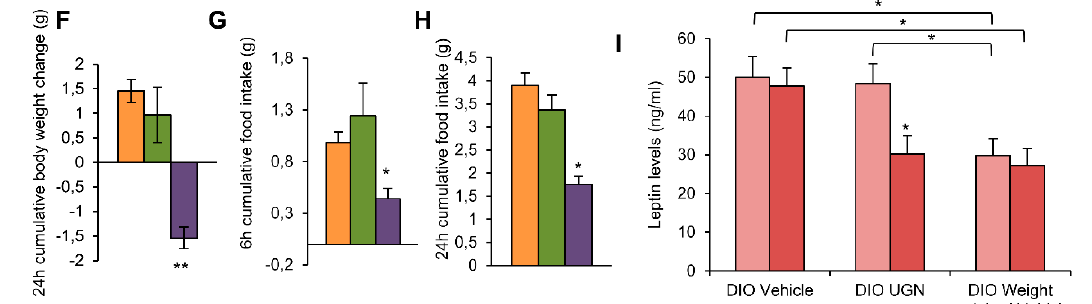
Figure 5. Effect of chronic ICV UGN (25 µ g/mouse) injection for four days and ICV leptin (3 µ g/mouse) for 24 h in DIO mice and weight-matched DIO mice on body weight ( A ). Effect of chronic ICV saline or UGN (25 µ g/mouse) injection for three days on body weight change ( B ) and food intake (C) in DIO mice. Effect of chronic ICV saline or UGN (25 µ g/mouse) injection for three days on body weight change ( D ) and food intake ( E ) in weight-matched DIO mice. Effect of ICV leptin (3 µ g/mouse) infusion in weight-matched DIO mice (the mice being pretreated with UGN (25 µ g/mouse/four days) and submitted to fasting the night before leptin injection) on a 24 h body weight change ( F ), six and 24 h cumulative food intake ( G and H respectively). Circulating leptin levels in DIO mice and weight-matched DIO mice treated with ICV vehicle or UGN ( I ). Values are represented as mean ± SEM; n = 5–14 animals per group. * p < 0.05; ** p < 0.01, *** p < 0.001 vs.